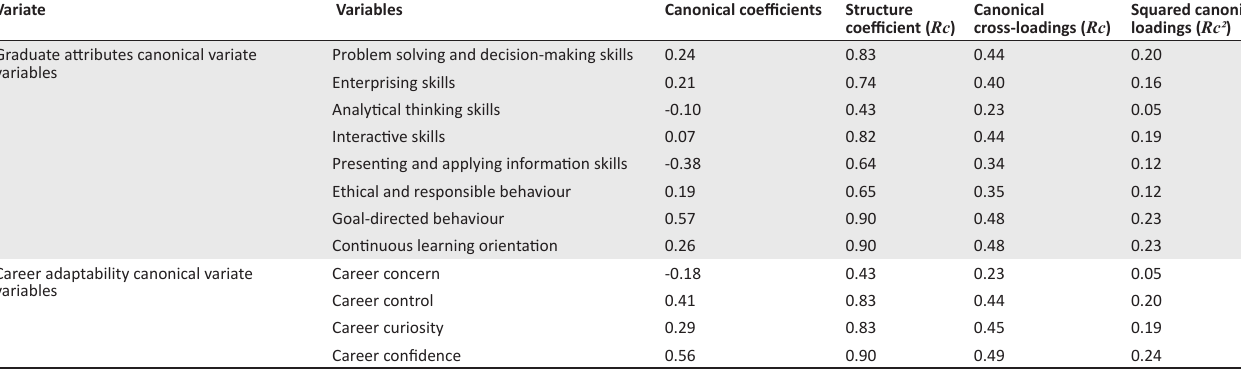
TABLE 2: Results of the standardised canonical correlation analysis for the first canonical function. Variate Variables Graduate attributes canonical variate